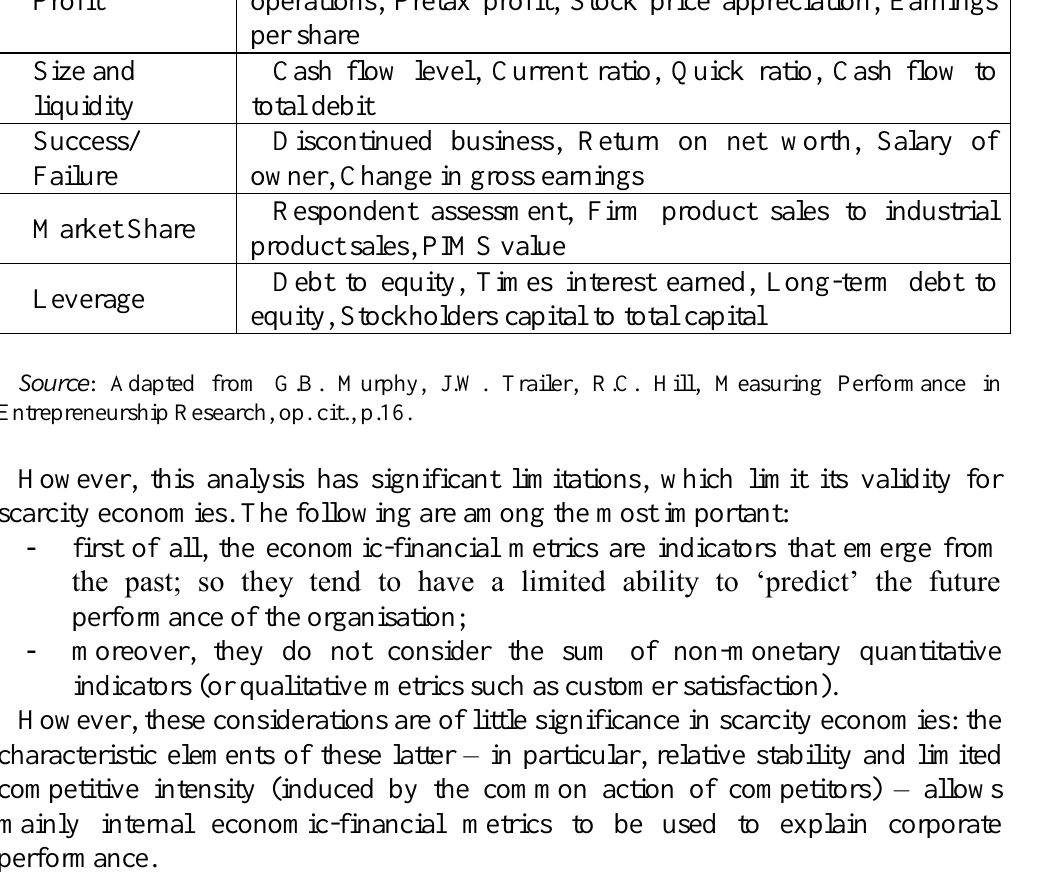
Table 1: Performance Dimensions and Related Indices Dimension Measure ROI, ROE, ROA, Return on net worth, Gross revenues Efficiency